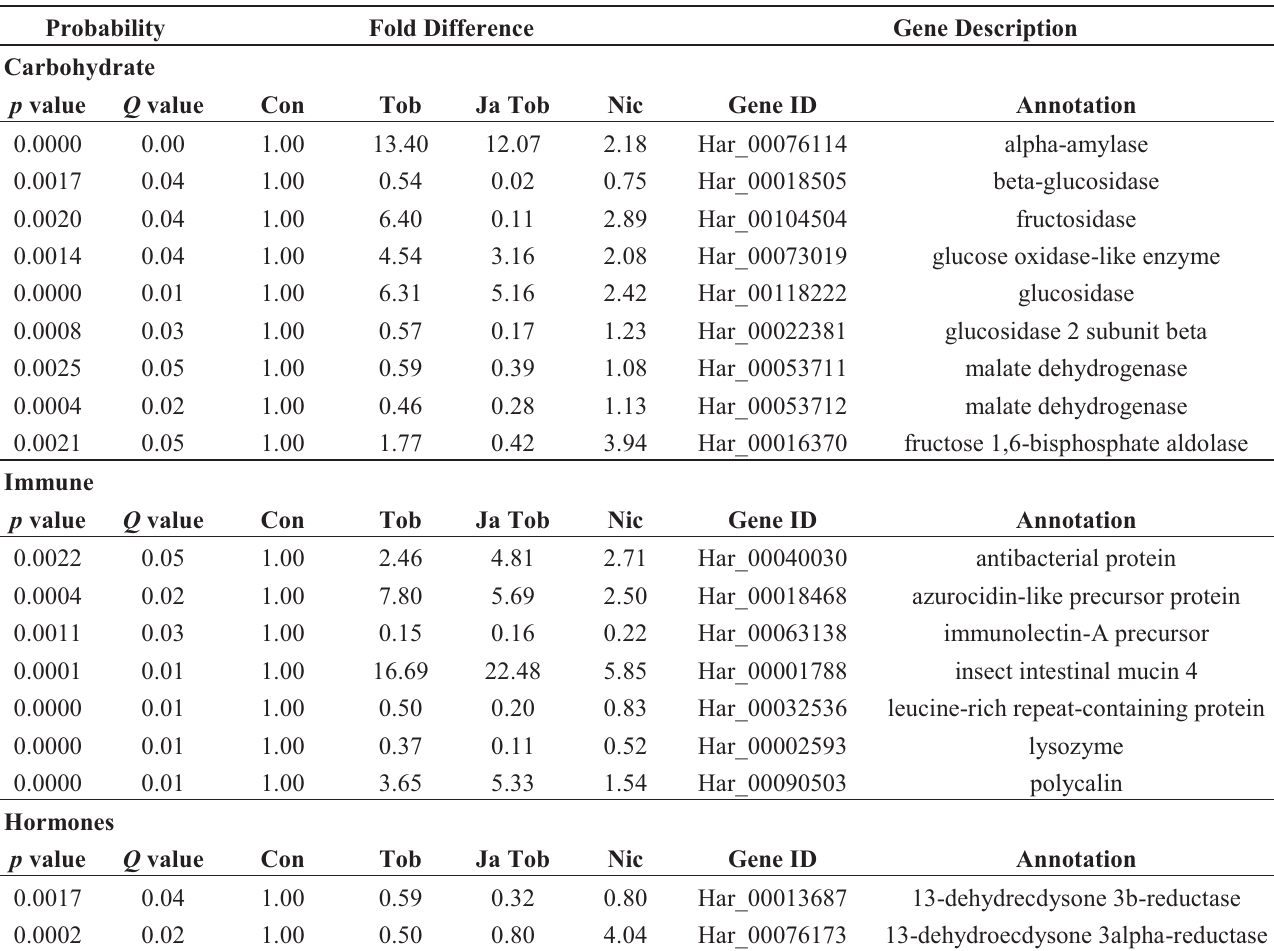
Table 3. Expression of carbohydrate, immune and hormone related genes. Gene name, fold change and NCBI reference sequence are